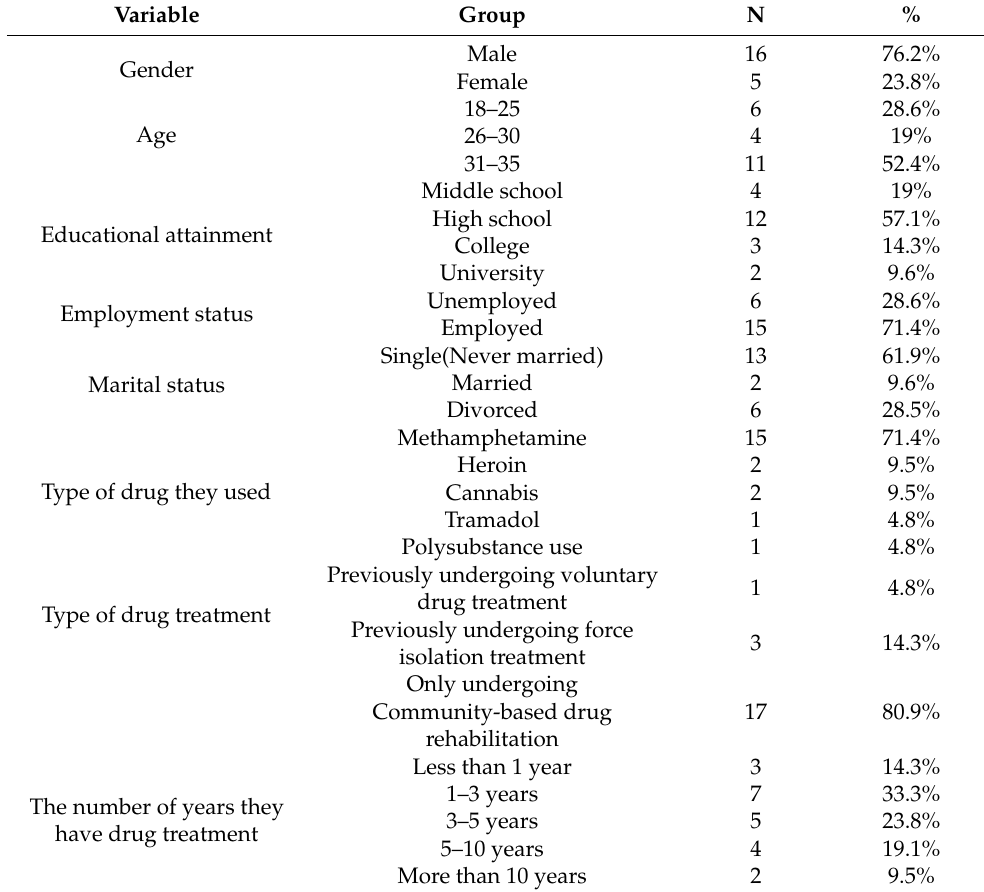
Table 1. Demographic data of participants (N =